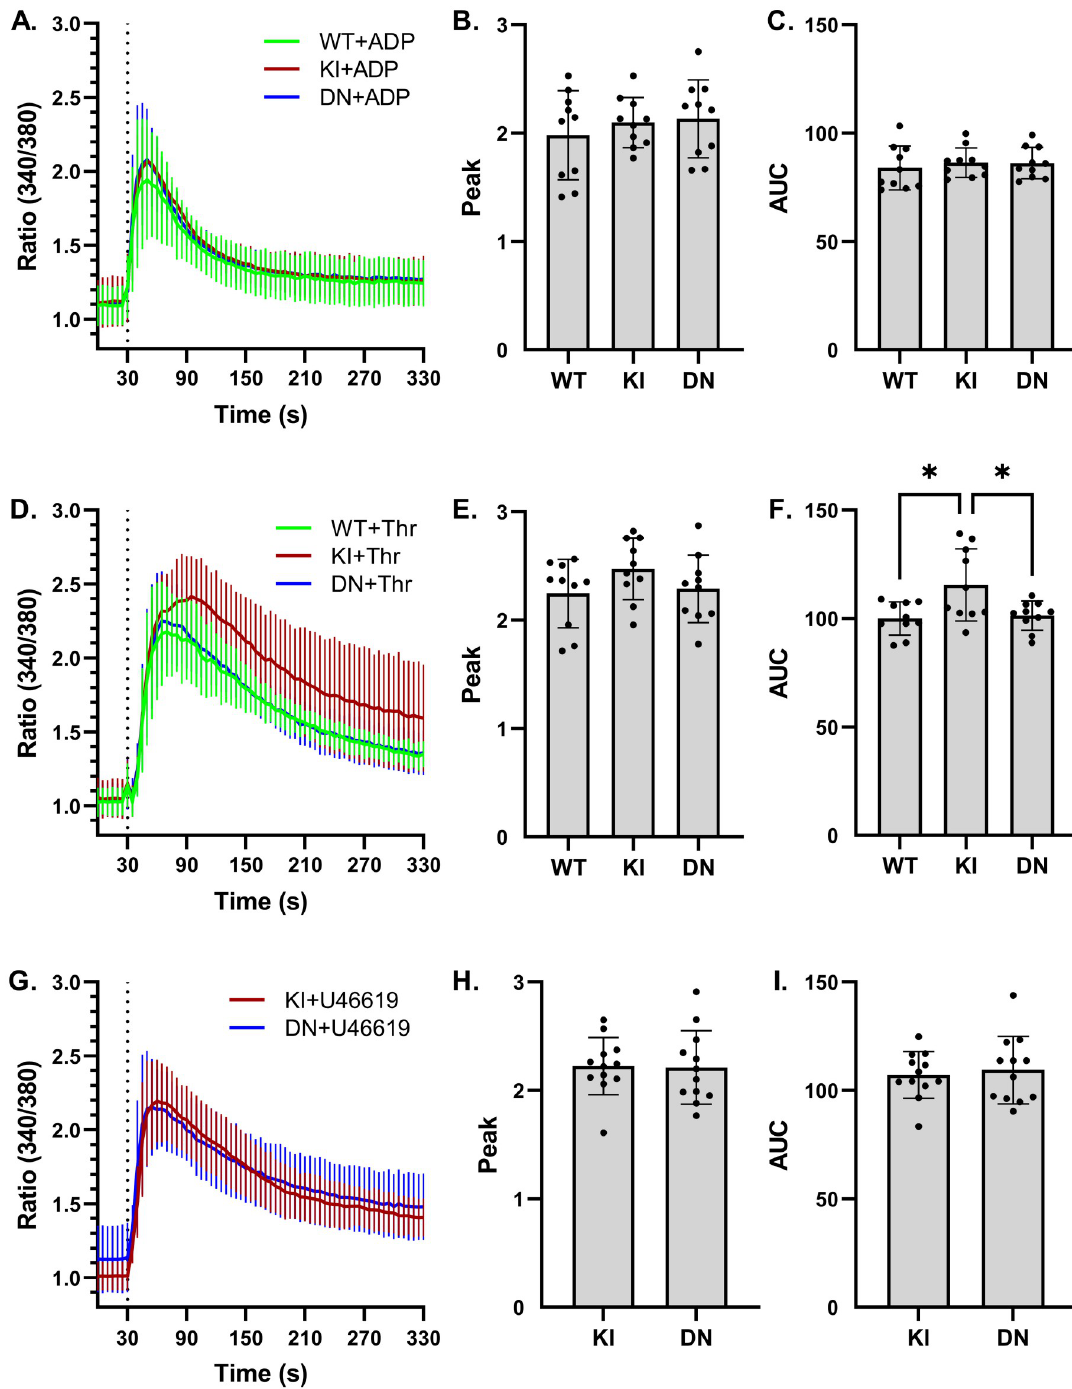
Fig 2. Effect of Trpc6 genotype on ADP, thrombin, and U46619-stimulated platelet calcium influx. A, Fura-2 fluorescence ratio (340/380) time-course in wild-type (WT), Trpc6 E896K/E896K (KI), and Trpc6 DN/DN (DN) platelets stimulated with ADP (final concentration 10 μ M) after 30 seconds (dashed vertical line); n = 8–10 using platelets from 6 mice per genotype. B, peak post- stimulation Fura-2 fluorescence ratios from ADP-stimulated traces shown in (A). C, area under the curve (AUC, arbitrary units) of the Fura-2 fluorescence ratio was calculated for each experiment shown in A. D, Fura-2 time course as in (A) above, but with thrombin (final concentration 0.5 u/ml) added at 30 seconds; n = 8–10 using platelets from 6 mice per genotype. Peak Fura-2 fluorescence ratio (E), and area under the curve (F), after thrombin stimulation of platelets from the indicated Trpc6 genotype. G, Fura-2 time course in KI